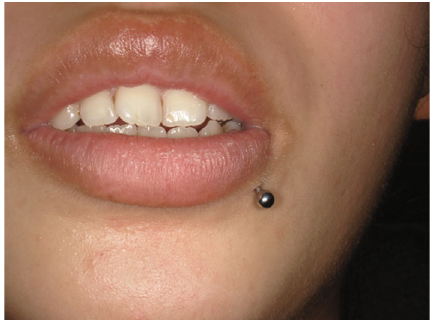
Figure 1: Extraoral fi ndings.